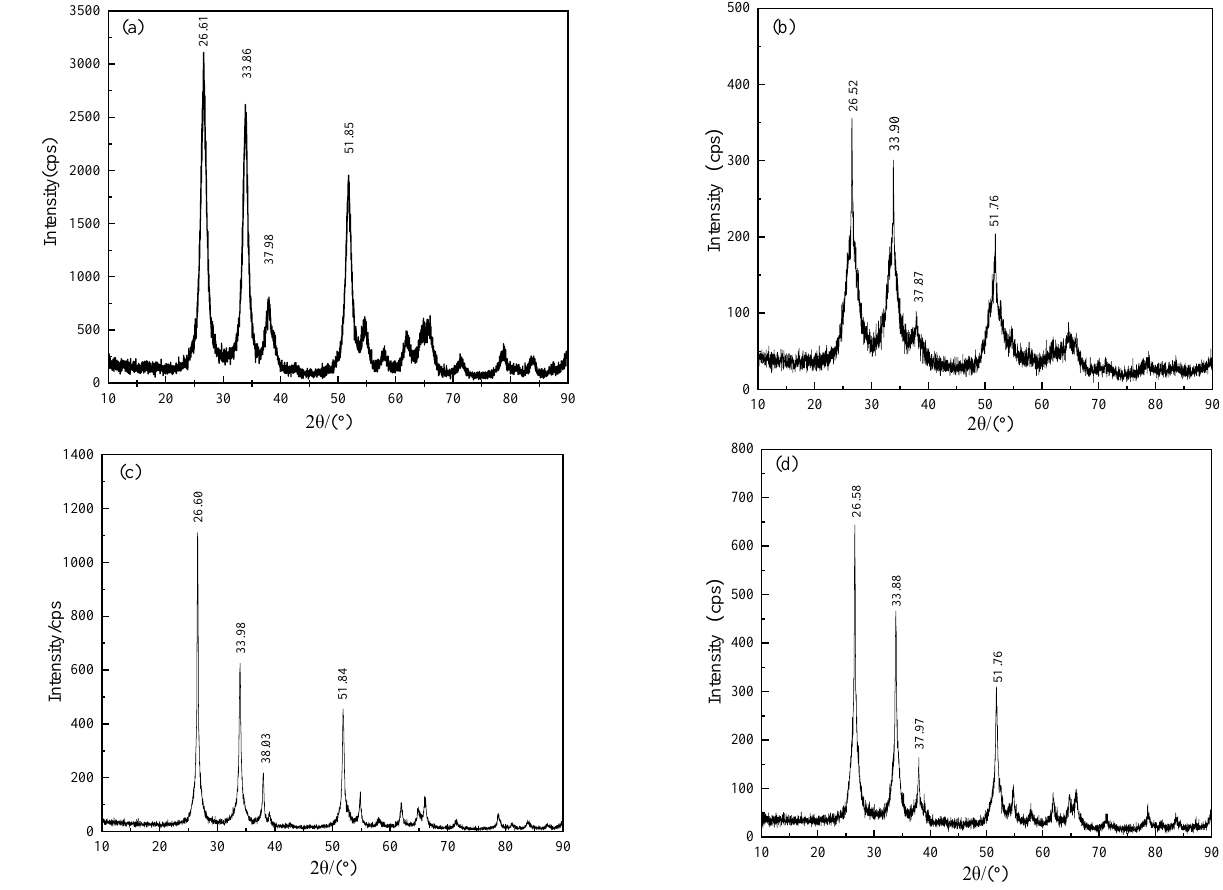
Figure 4. X-ray diffraction pattern: ( a ) SnO 2 ; ( b ) Y-doped SnO 2 ; ( c ) Mo-doped SnO 2 ; ( d ) Y-Mo co-doped SnO 2 .